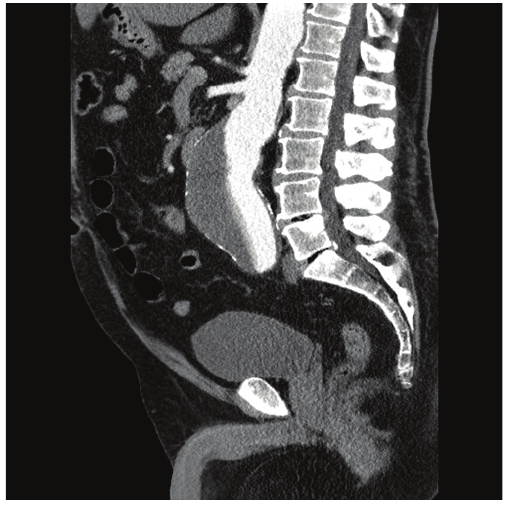
Figure 1: Juxtarenal abdominal aortic aneurysm 66 × 150mm.